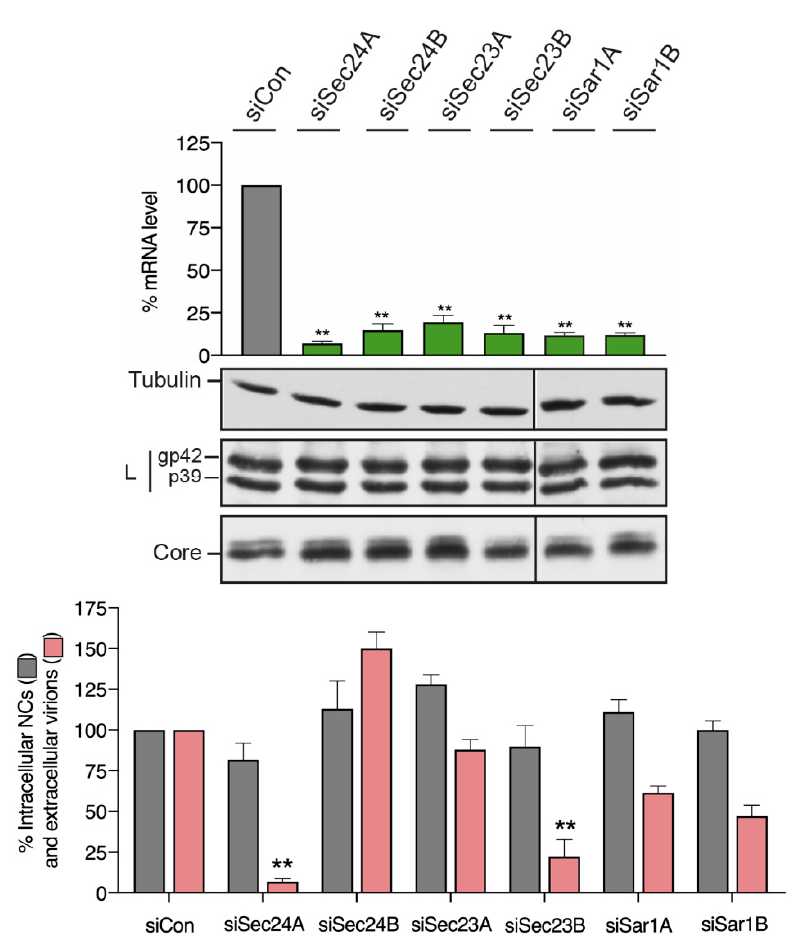
Figure 3. HBV release requires COPII components. HuH-7 cells were treated with control siRNA (siCon) or siRNAs targeting Sec24A, Sec24B, Sec23A, Sec23B, Sar1A or Sar1B for 48 h and retransfected with the pHBV* replicon. After an additional 72 h, lysates and supernatants were harvested. To check for depletion, transcript levels of the RNA interference (RNAi)-targeted genes were measured by qRT-PCR and demonstrated in percent amount relative to control cells ( n = 4, ± SD). To monitor protein synthesis, cell lysates were examined by WB using tubulin-, L- (K1350) and core-specific (K46) antibodies. The nonglycosylated (p39) and glycosylated (gp42) forms of L are indicated. HBV release was measured by envelope-specific IP of supernatants using anti-L (K1350) and anti-S (K38) antibodies and real-time multiplex PCR measurements of the viral genomes (extracellular virions). Nonenveloped intracellular nucleocapsids (intracellular NCs) were immunoprecipitated with anti-capsid (K45) antibodies and analyzed by PCR. PCR results were demonstrated in the percent amount relative to siCon-transfected cells. Error bars indicate the standard deviations from the mean of three experiments measured in duplicates. ** p < 0.01 compared to control.